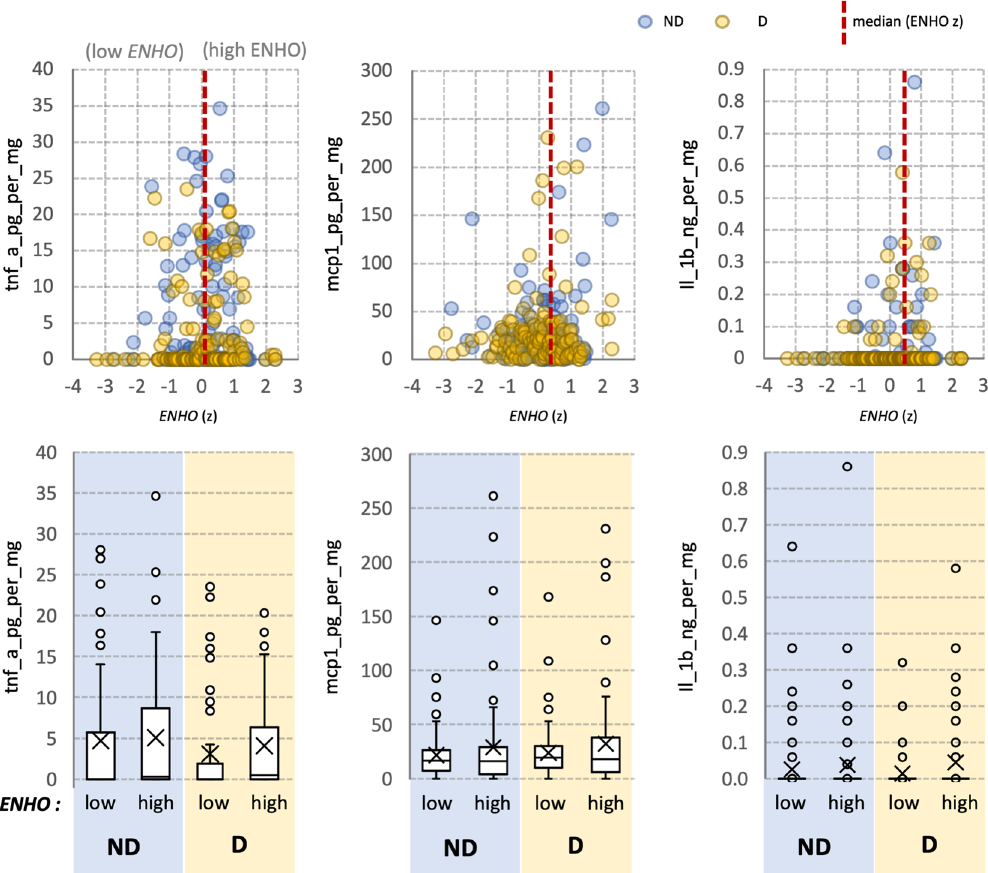
Fig. 4 Relationships between ENHO expression and protein markers of neuroin fl ammation in study participants. The top three panels show the data as scatterplots; TNFa, MCP1 or IL1b are plotted against relative ENHO expression. The bottom three panels show TNFa, MCP1 or IL1b in participants divided into two groups (below or above the median, labelled “ low ” or “ high ” ) after being ranked by ENHO